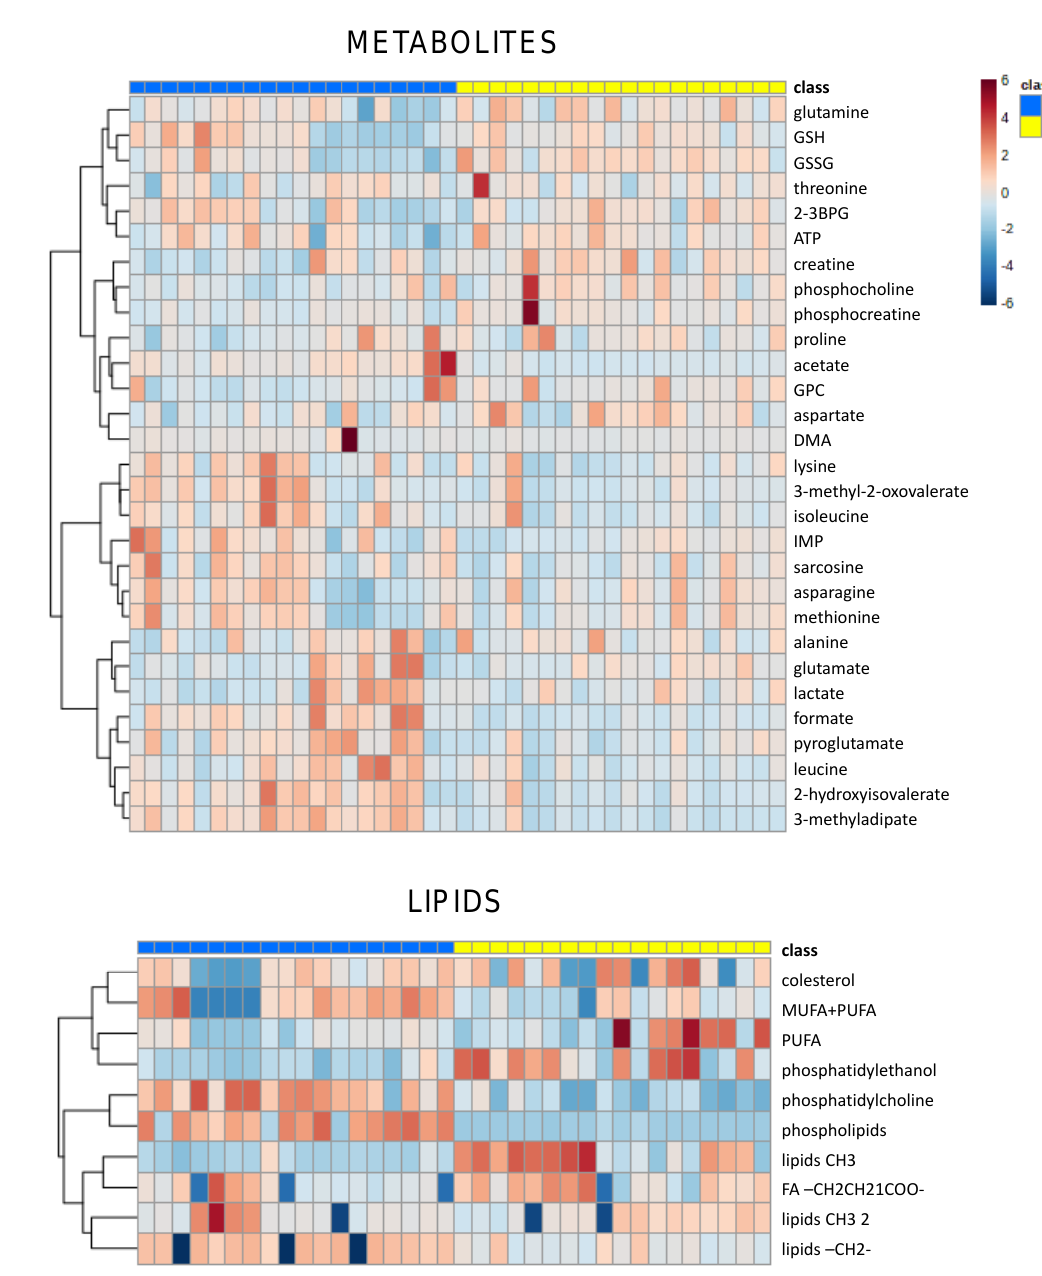
Figure 2. Heatmap analysis performed with the Ward clustering algorithm and ANOVA test. ( A ) Heatmap showing main aqueous metabolites. ( B ) Heatmap showing the main lipid groups. GSH = reduced glutathione, GSSG = oxidized glutathione, 2,3-BPG = 2,3-Bisphosphoglyceric acid, GPC = glycerophosphocholine, DMA = dimethylamine, IMP = inosinic acid, MUFA = monounsaturated fatty acids, PUFA = polyunsaturated fatty acids, CH3 = methyl group, FA = fatty acids, CH2 = lipid chain. The color scale refers to normalized concentration